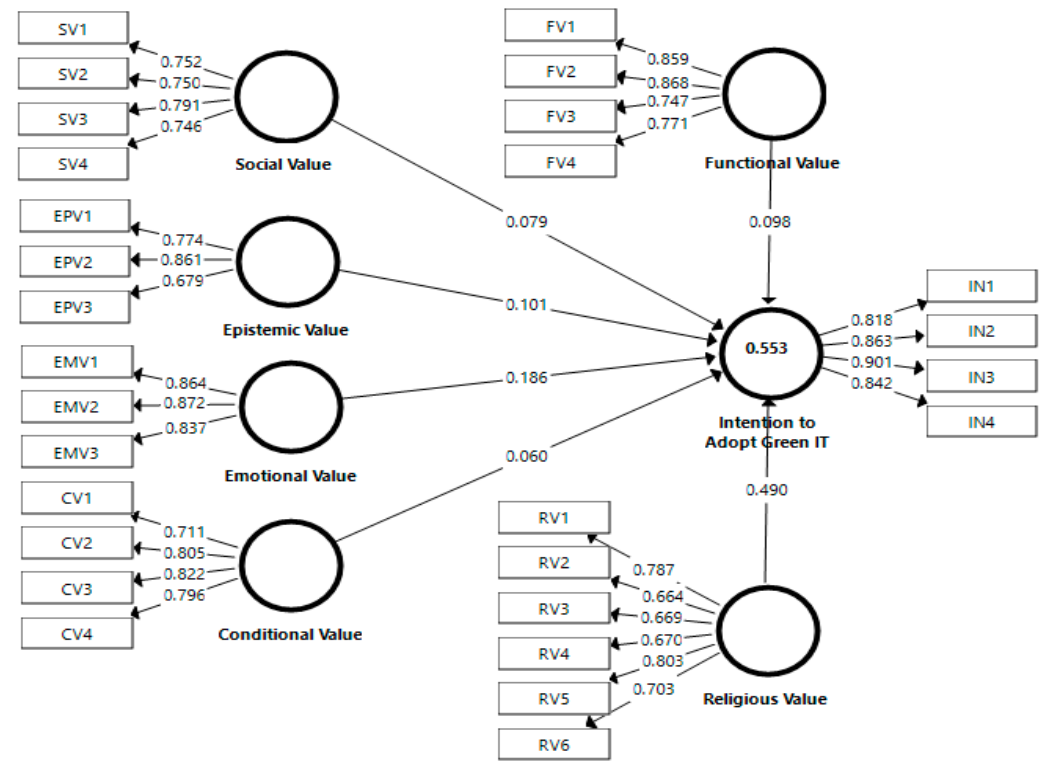
Figure 2. Measurement Model (PLS Algorithm results)